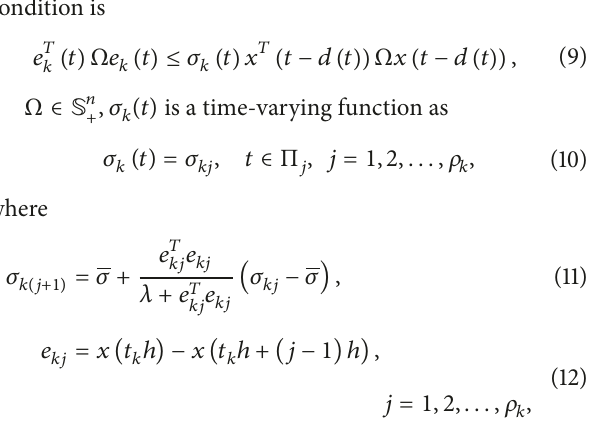
system. It is assumed that the sampling sequence is S 𝑠 = {0, ℎ, 2ℎ, . . . , 𝑛ℎ} . Suppose 𝑡 ℎ is the next released time. In addition, 𝑡 𝑡 𝑘+1 where 𝑛ℎ is the release interval of the transmitted